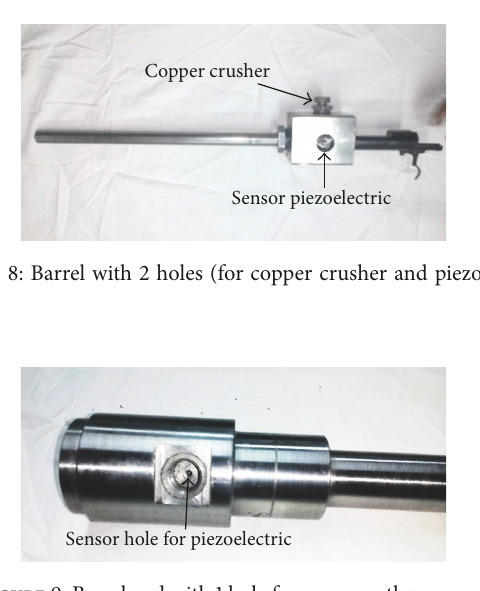
Figure 9: Barrel end with 1 hole for case mouth pressure.